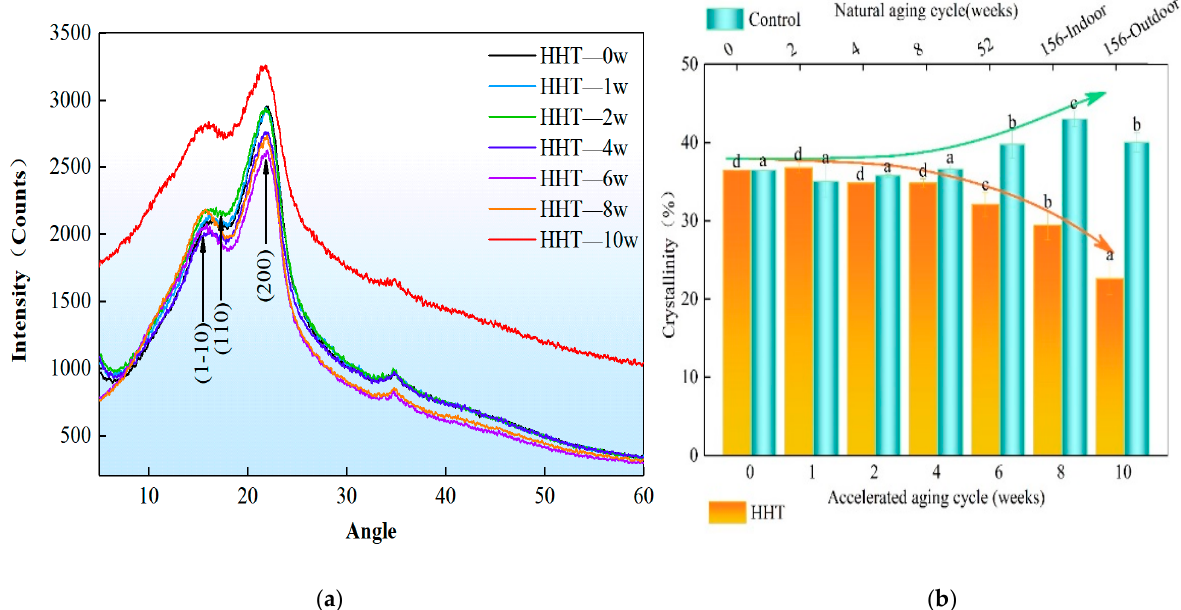
Figure 6. XRD patterns of bamboo during humid and heat cycle ageing. ( a ) Diffraction of x-rays patterns of all samples. ( b ) Cellulose crystallinity of all samples measured by peak height method. Note: Different lowercase letters between the two groups indicate significant differences ( p < 0.05). Table 3. Values of cellulose crystallinity during aging of bamboo ANOVA.